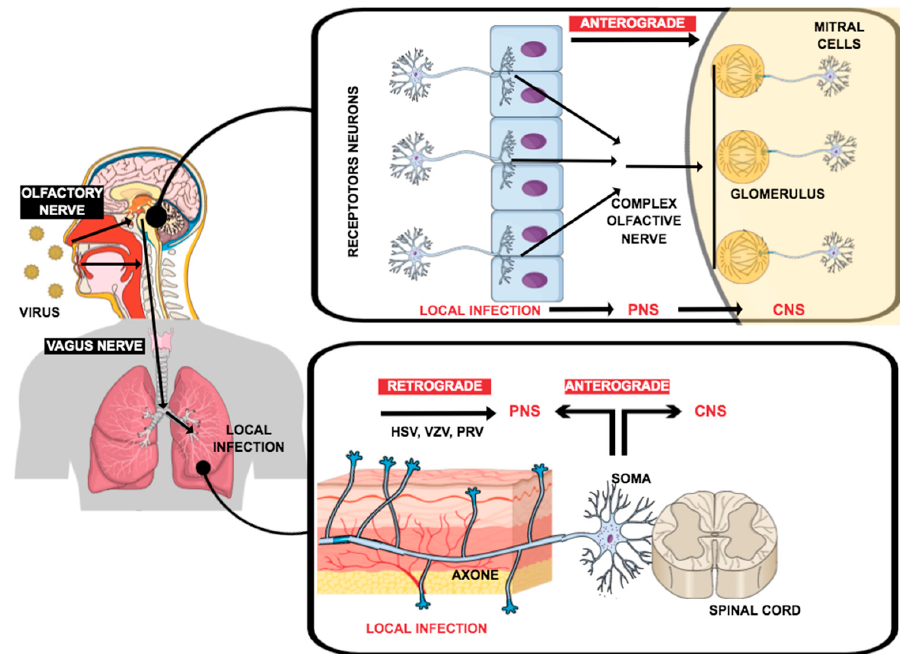
Figure 1. Pathways through which viruses can infect the peripheral nervous system (PNS) or central nervous system (CNS): (1) nerve endings were accessed in the tissues by the infection using axonal transport machinery to gain access to the CNS; or (2) by the infected cells in a circulatory system, which carries the infection through the blood–brain barrier into the CNS. Adapted from Yachou et al., 2020 [98].